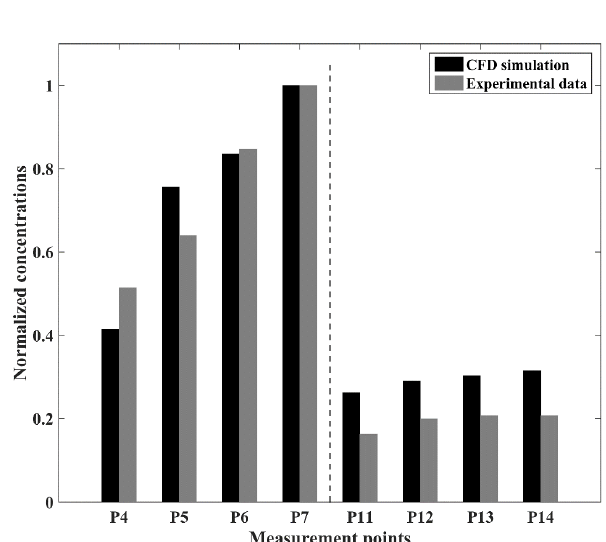
Figure 6. The stream-wise velocity profiles along Line F.